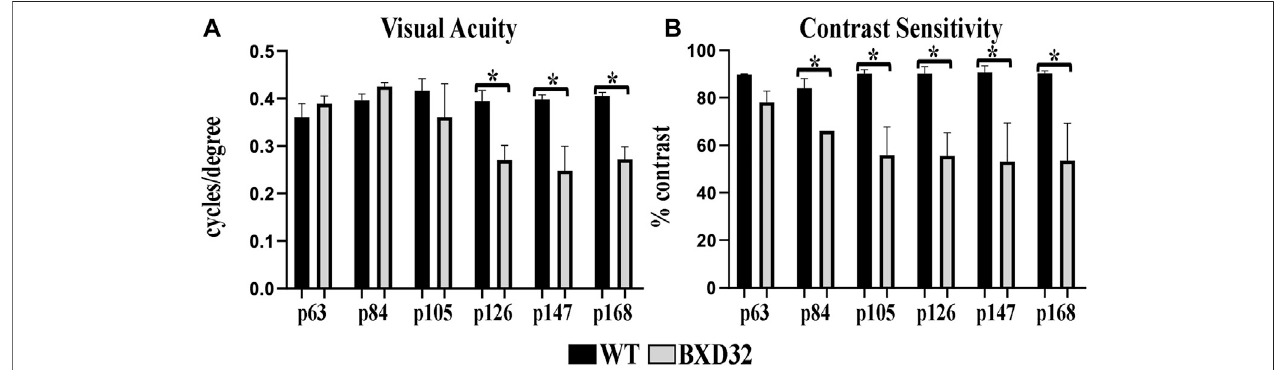
FIGURE 1 | The BXD32 mouse retina exhibits diminished visual ability by OKN. WT and BXD32 mice were examined using OKN to assess for visual acuity ( VA, A) and contrast sensitivity ( CS , B) , respectively. BXD32 mice exhibit a loss of visual acuity beginning around p105 and dropping signi fi cantly by p168. Similarly, but beginning much earlier at p63, the BXD32 mice lose contrast sensitivity compared to WT mice to levels roughly half of WT animals by p168. Error bars = ±SEM. *, p <